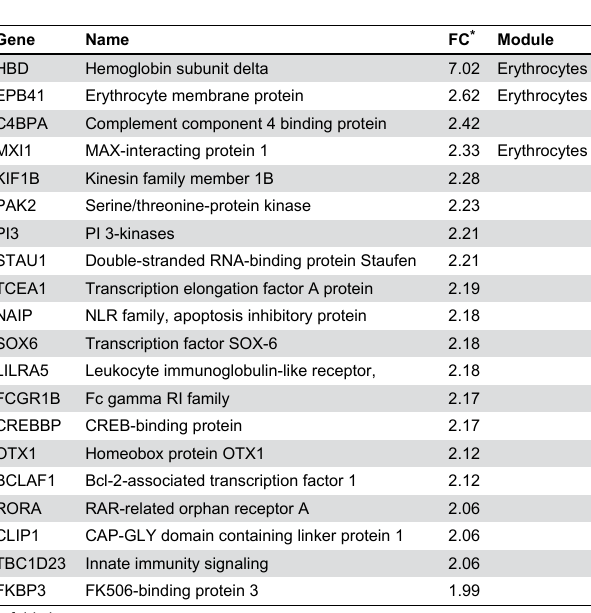
Table 3. Up-regulated genes: Healthy Controls vs. all CVID subjects.